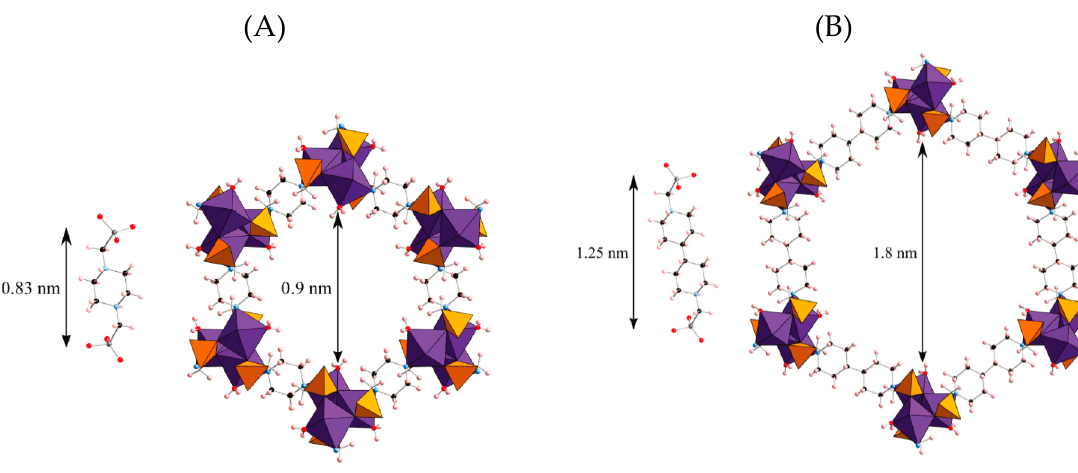
Figure 3. Frameworks of STA-12 ( A ) and STA-16 ( B ) viewed along the channel axis. Color code: cobalt: purple, phosphorus: orange, oxygen: red, nitrogen: blue, carbon: black, hydrogen: pink. Reprinted with permission from [51]. Copyright (2011), American Chemical Society.